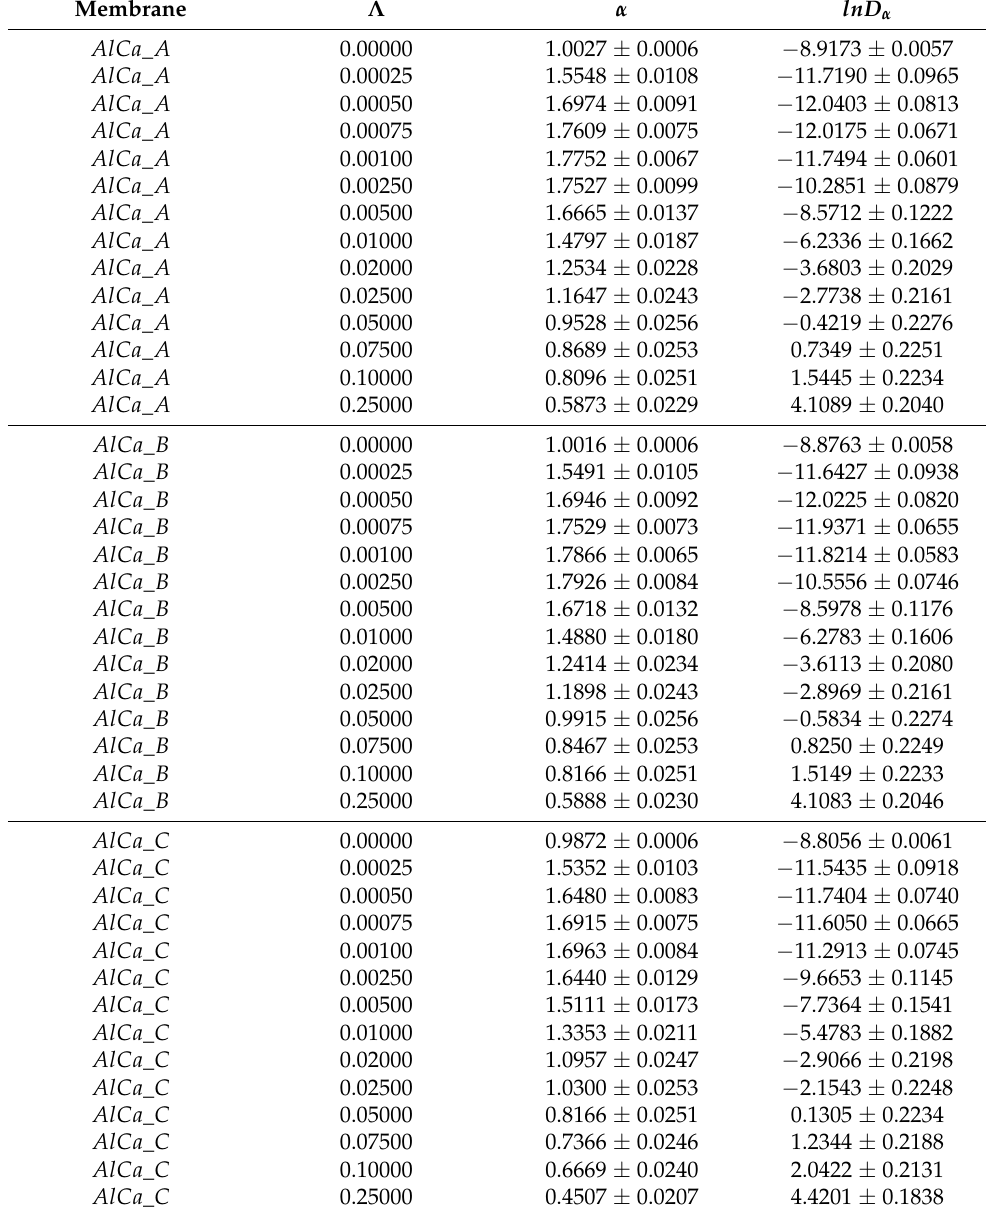
Table A1. Transport properties of alginate membrane cross-linked by calcium chloride, containing 15 wt% of magnetite